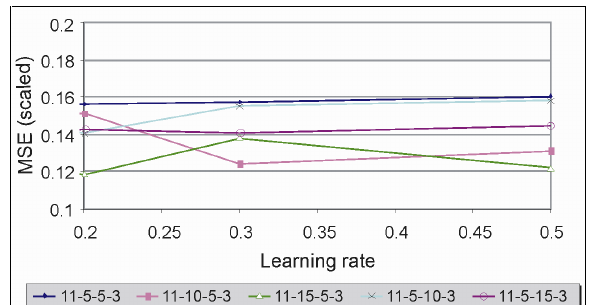
Fig. 4. Mean squared error (MSE) for two hidden layer